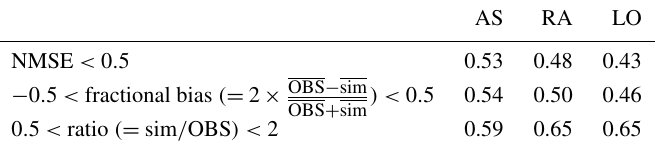
Table 3. Values of the three criteria suggested in Kumar et al. (1993).